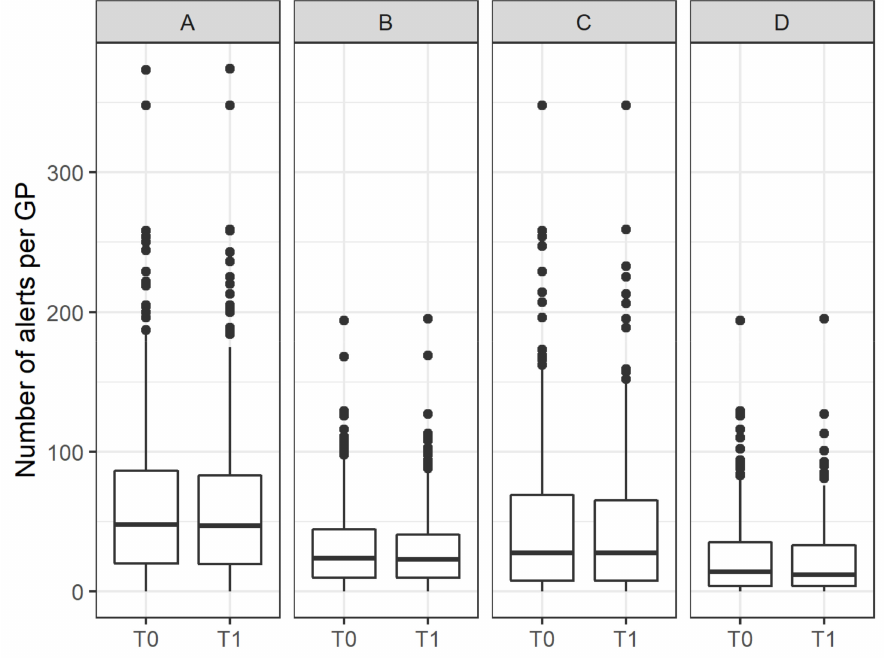
Figure 3. Box plot showing the number of alerts per GP at T 0 and T 1 ( A ), stratified according to the subgroups “severe alerts” ( B ), “completed anamnesis” ( C ) and a combination of both subgroups ( D